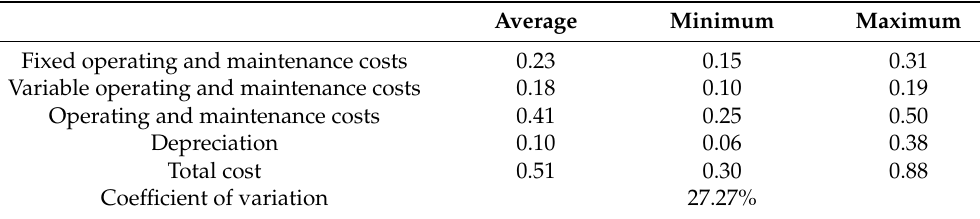
Table 6. Cost in € per m 3 of billed water in the province of Ja é n in 2017.